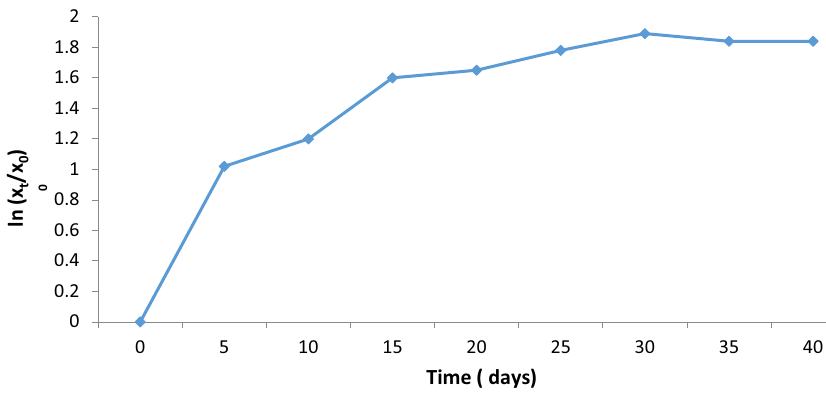
Fig. 1 Growth curve of C. vul- garis: temperature (35 ± 2 °c), OD at 686 nm, time (till 40 days)